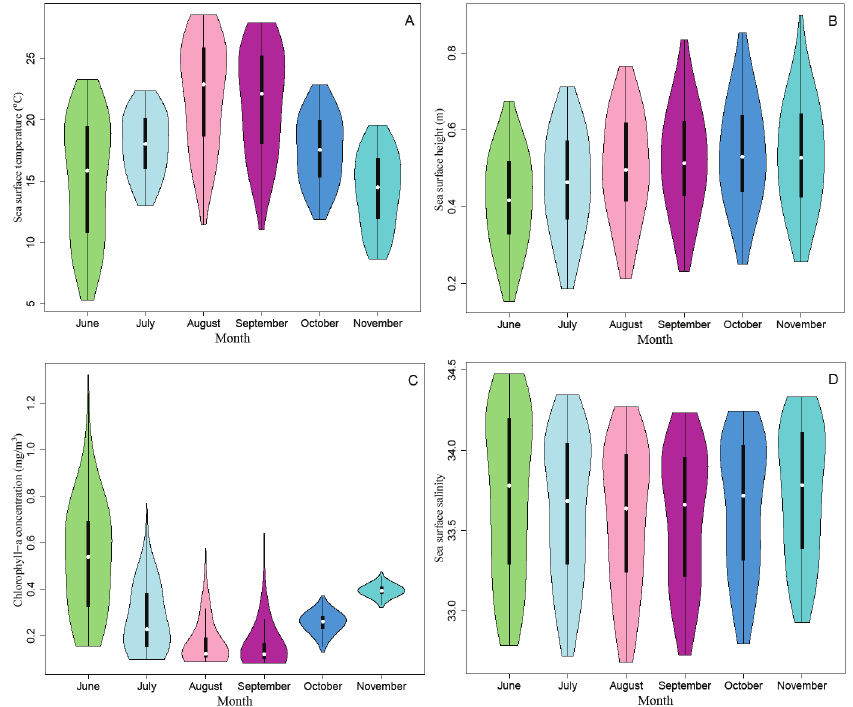
Figure 6. Monthly satellite-based ( A ) SST, ( B ) SSH, ( C ) Chla and ( D ) SSS values for the fishing grounds of the Pacific sardine fishery between 2015 and 2020.